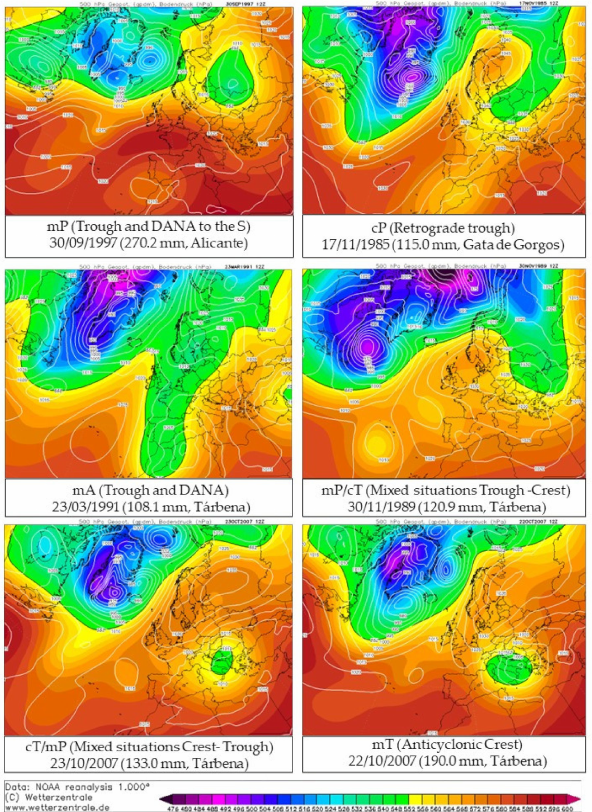
Figure 5. Representative examples of different synoptic situations for the classification by Olcina Cantos [14] on days presenting ≥ 100 mm rainfall. Source: www.wetterzentrale.de (consulted 24 March